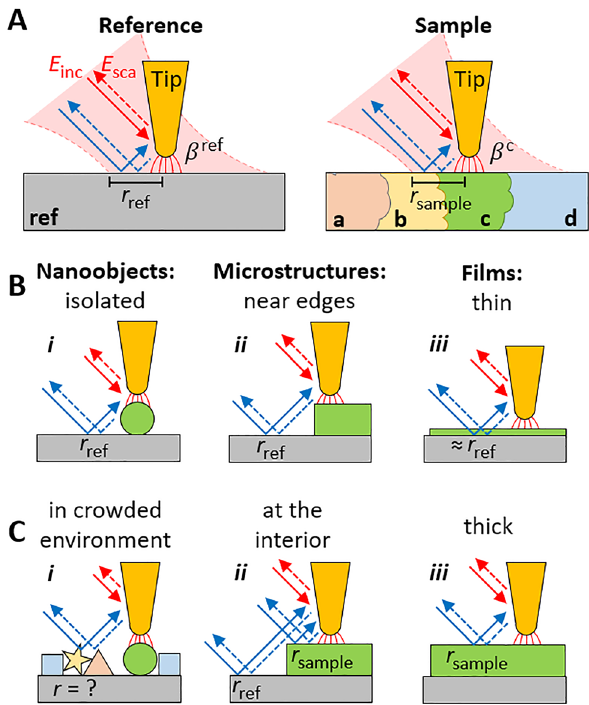
Figure 1: Illustration of typical s-SNOM and nano-FTIR experiments. (A) A metallized AFM tip near a known reference material (left) or unknownsample (right, generic sample composed of materials a, b, c, d) is illuminated by the electric field E inc of a diffraction-limited infrared laser beam (red area). Near- fi eld interaction between tip and sample modi fi es the tip-scattered light, E sca , depending on the electrostatic re fl ection coef fi cient β j of the material j below the tip apex. The tip is illuminated (and the tip-scattered light is detected) directly (red arrows) and indirectly via far- fi eld re fl ection at the sample surface (blue arrows), depending on the far- fi eld re fl ection coef fi cient r j . (B) Situations where far- fi eld re fl ections cancel upon signal normalization: ( i ) isolated nanoobjects, ( ii ) near edges of extended microstructures, ( iii ) thin fi lms with negligible absorption and re fl ection, all placed on the reference material. (C) Situations where far- fi eld re fl ections do not cancel: ( i ) nanoobjects in crowded environments, ( ii ) at the interior of microstructures, ( iii ) thick fi lms, all placed on the reference material and exhibiting signi fi cant ab- sorption or re fl